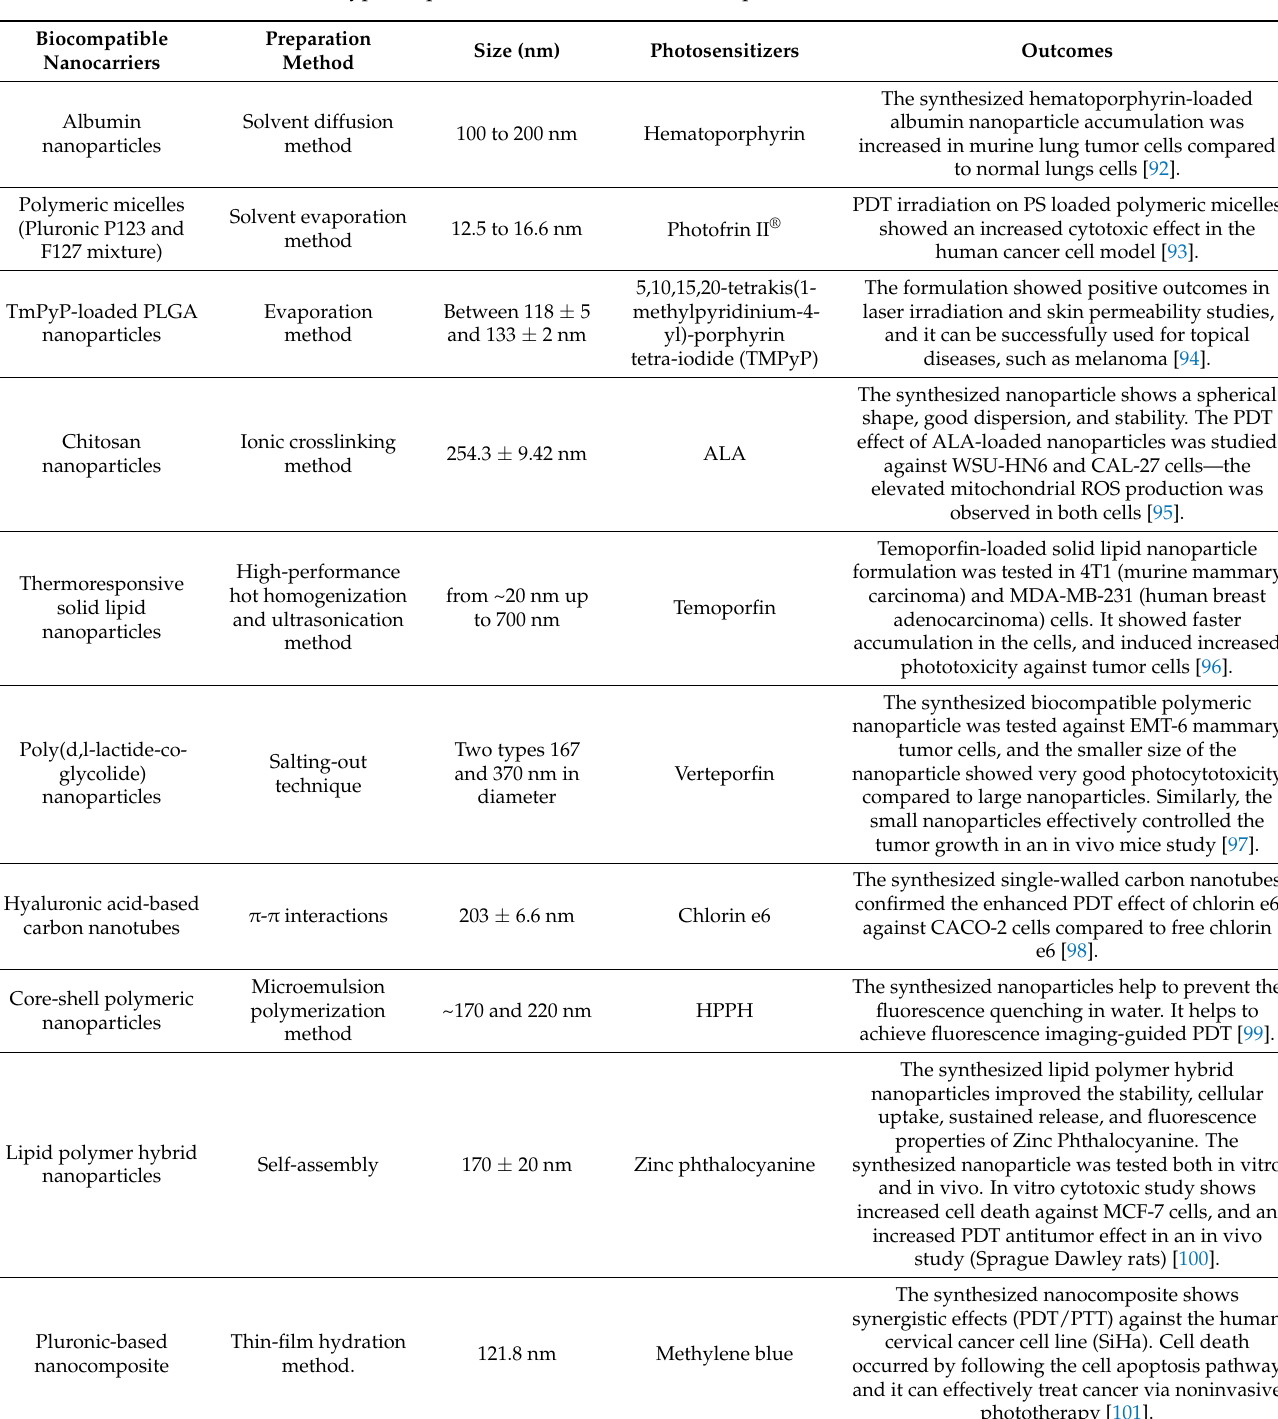
Table 1. Different types of photosensitizers-loaded biocompatible nanocarriers in PDT for